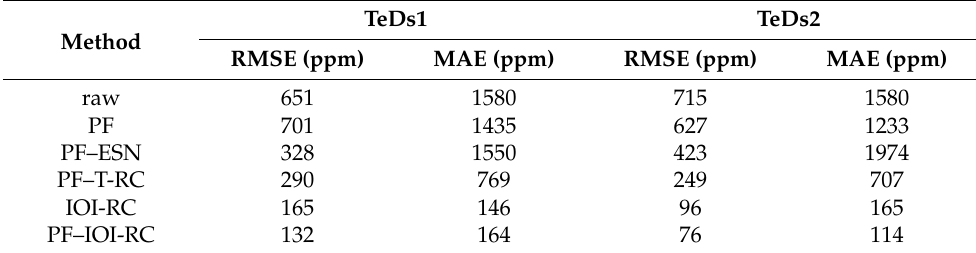
Table 2. Performance comparation of dynamic temperature compensation